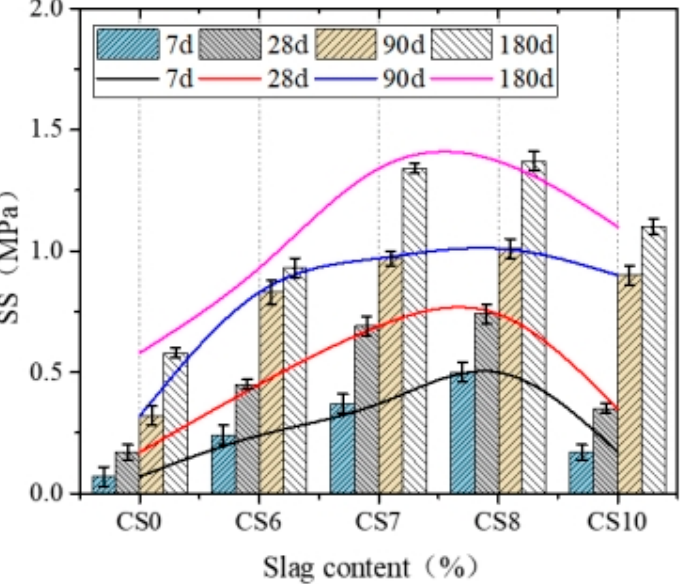
Figure 6. Effect of CFBS content on the SS of cement-stabilized clay. The error bars represent the standard deviation of the test results for five samples.